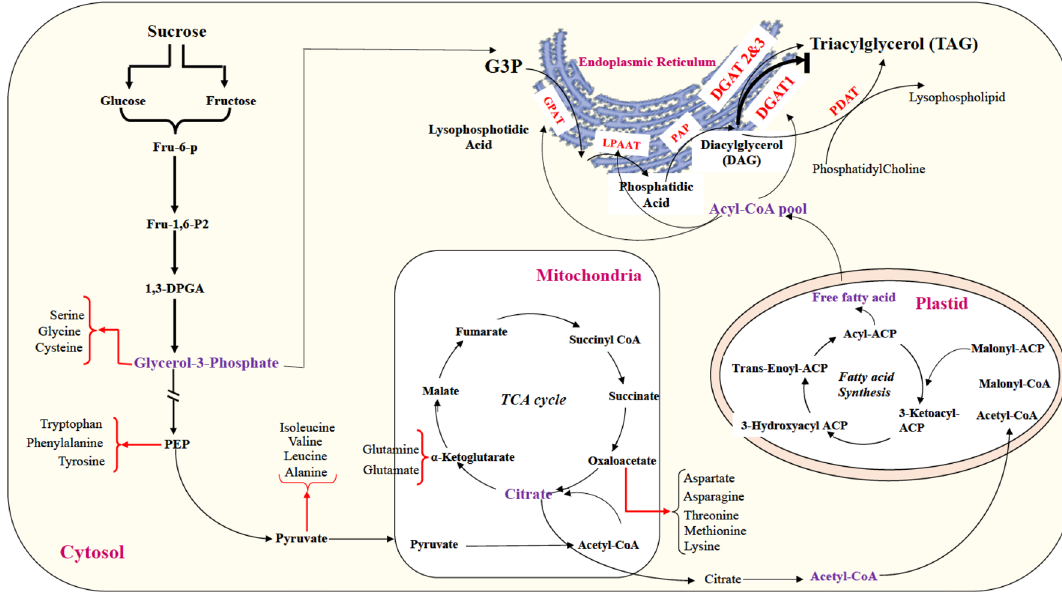
Figure 10. Suppression of DGAT1 isoforms and its feedback on cytosolic glycolysis, TCA cycle, Fatty acid synthesis and Kennedy pathways products. Dash lines indicate less activity of these pathways in transgenic lines and cause the accumulation of their precursor. Red arrows indicate alternative pathways because of facing accumulation of some precursor following DGAT1 suppression in transgenic lines. The thick black arrow indicates the higher DGAT1 enzymatic